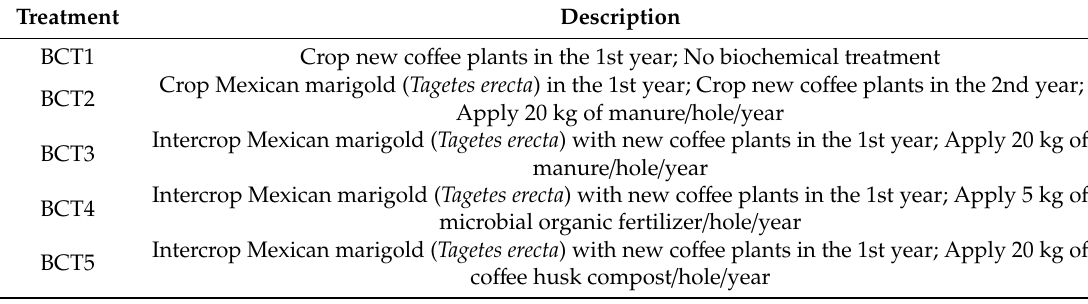
Table 1. Biochemical treatments to improve soil chemistry.